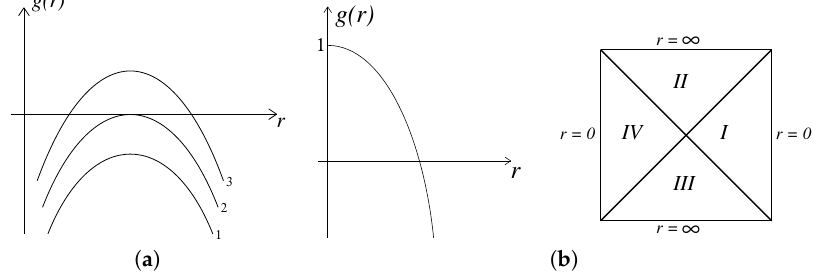
Figure 5. Evolution of the Schwarzschild-de Sitter black hole in the case of complete evaporation. ( a ) Schwarzschild-de Sitter metric function; ( b ) De Sitter metric function and global